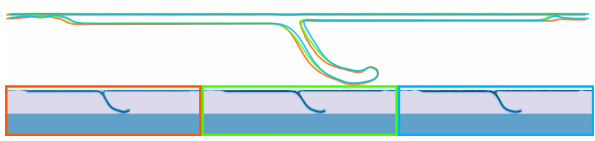
Figure 9. 550K isotherm for models 3 (left/orange), 2 (cen- ter/green), and 1 (right/blue). Surface plates are 50km thick and have a maximum viscosity of 10 23 Pas; the slab strength for mod- els 3, 2, and 1 is 10 23 Pas, 10 22 Pas, and 10 21 Pas respectively. Subfigures show viscosity for each model.